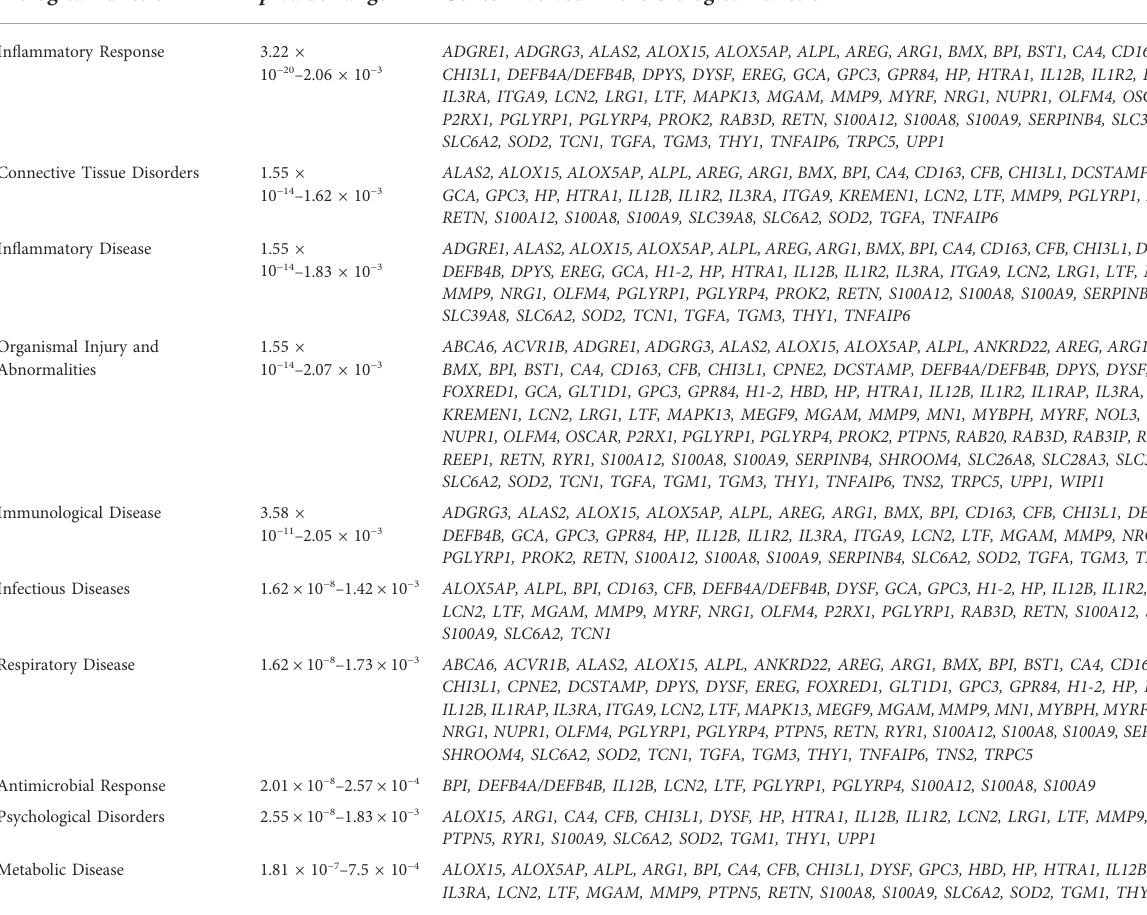
TABLE 3 Ten topmost signi fi cantly enriched biological functions associated with differentially expressed genes. Biological function p -value range Genes involved in the biological